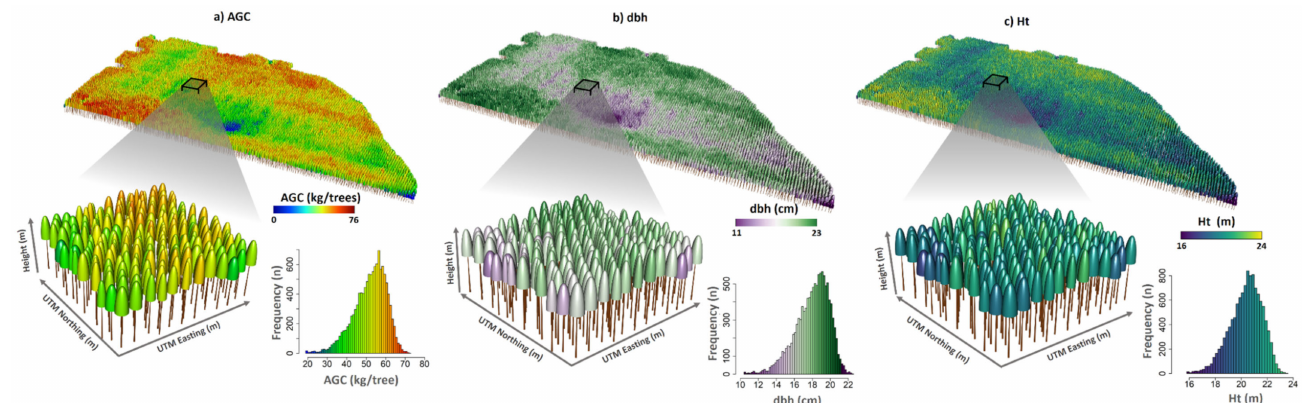
Figure 9. Example of forest attributes estimated at tree level and their distribution within an entire 3.9 year-old stand; ( a ) aboveground carbon (AGC), ( b ) diameter at 1.3 m above the ground (dbh), and ( c ) height (Ht) estimated from the linear mixed-e ff ect model